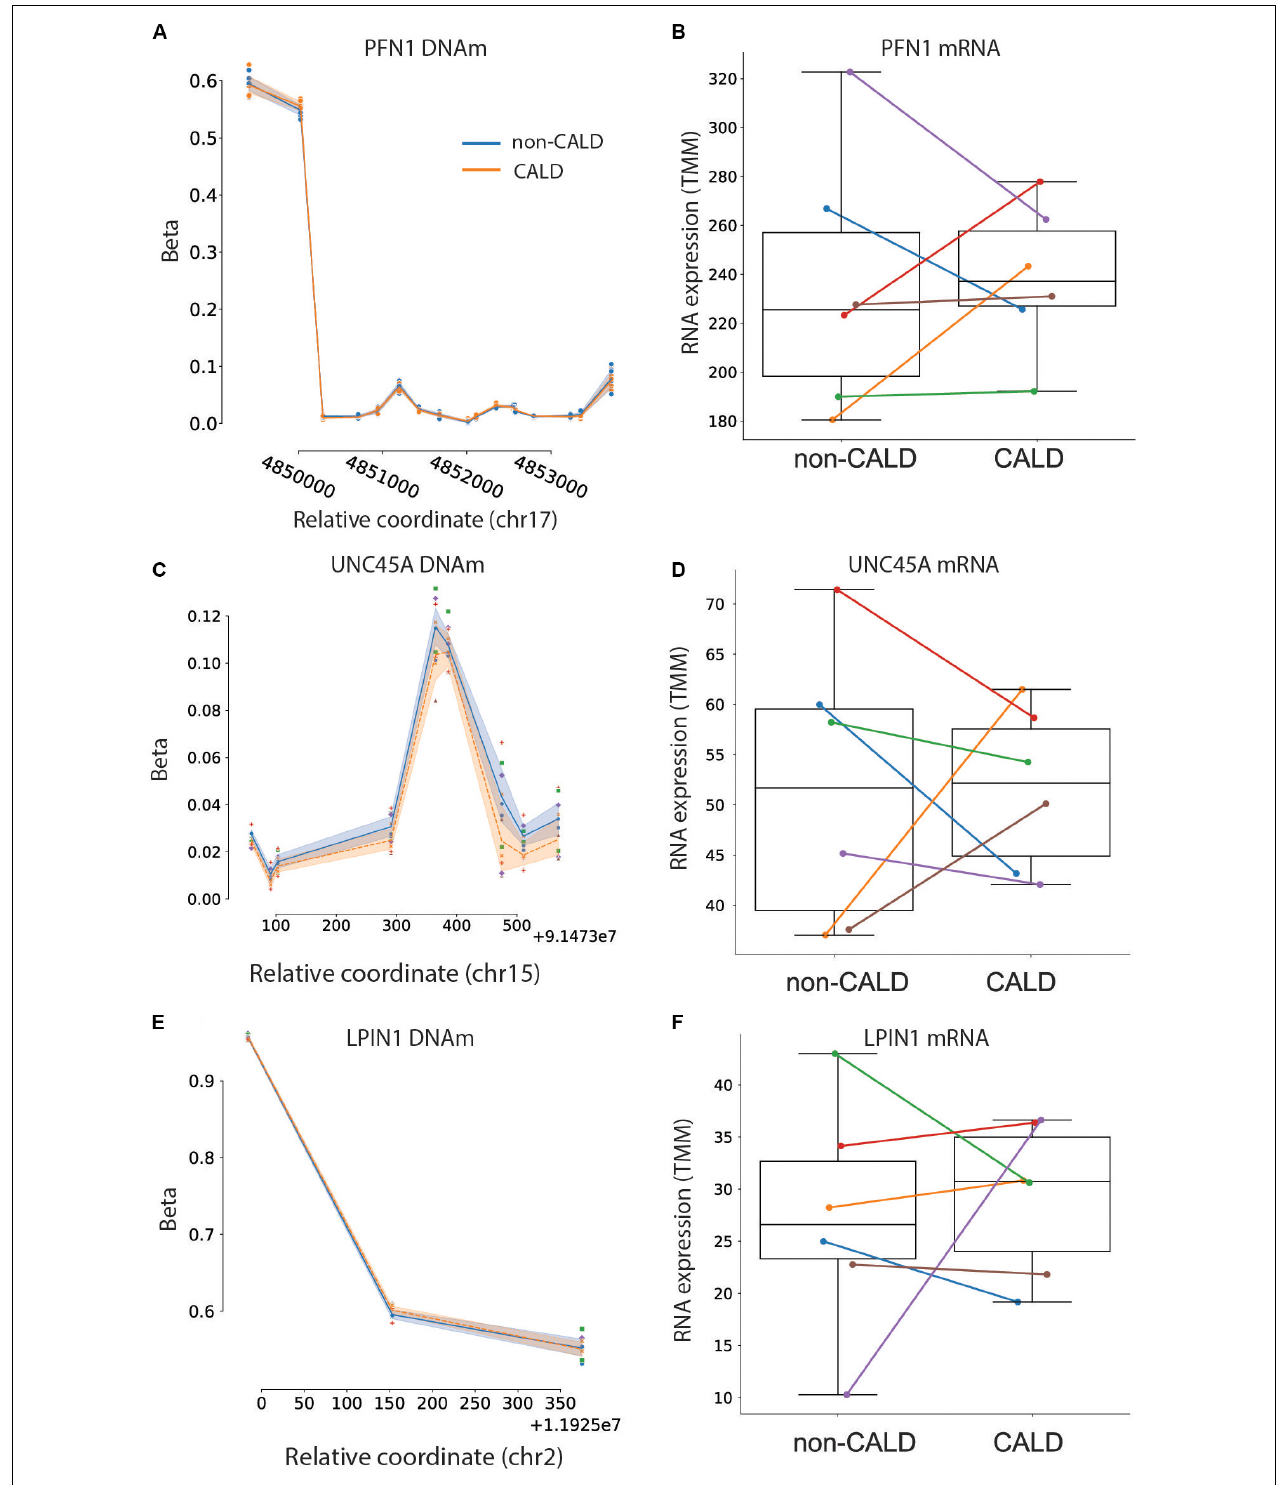
FIGURE 5 | Testing previously suggested markers. DNA methylation and mRNA abundance for PFN1 (A,B) , UNC45A (C,D) , and LPIN1 (E,F) . DNA methylation is shown for all CpGs associated to the listed genes, with the non-CALD mean methylation shown as a blue line with standard error shading, and the orange dashed line showing the mean methylation of CALD. Individual points are shown and colored by family. RNA expression is shown as a boxplot for non-CALD and CALD phenotype groups, with individual families labeled with family 1 as blue, family 2 as orange, family 3 as green, family 4 as red, family 5 as purple, and family 6 as